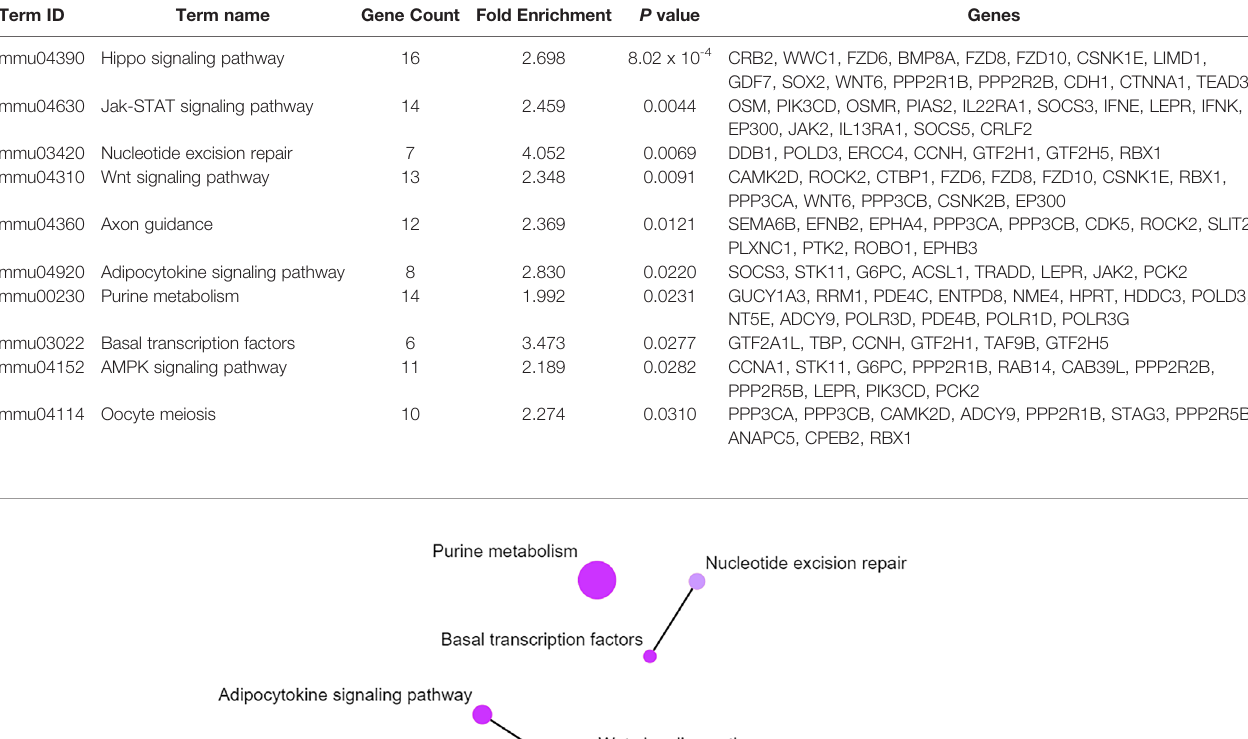
TABLE 4 | The enriched KEGG pathway with differentially methylated genes in DIO-CD offspring vs NC-CD offspring ( P < 0.05).